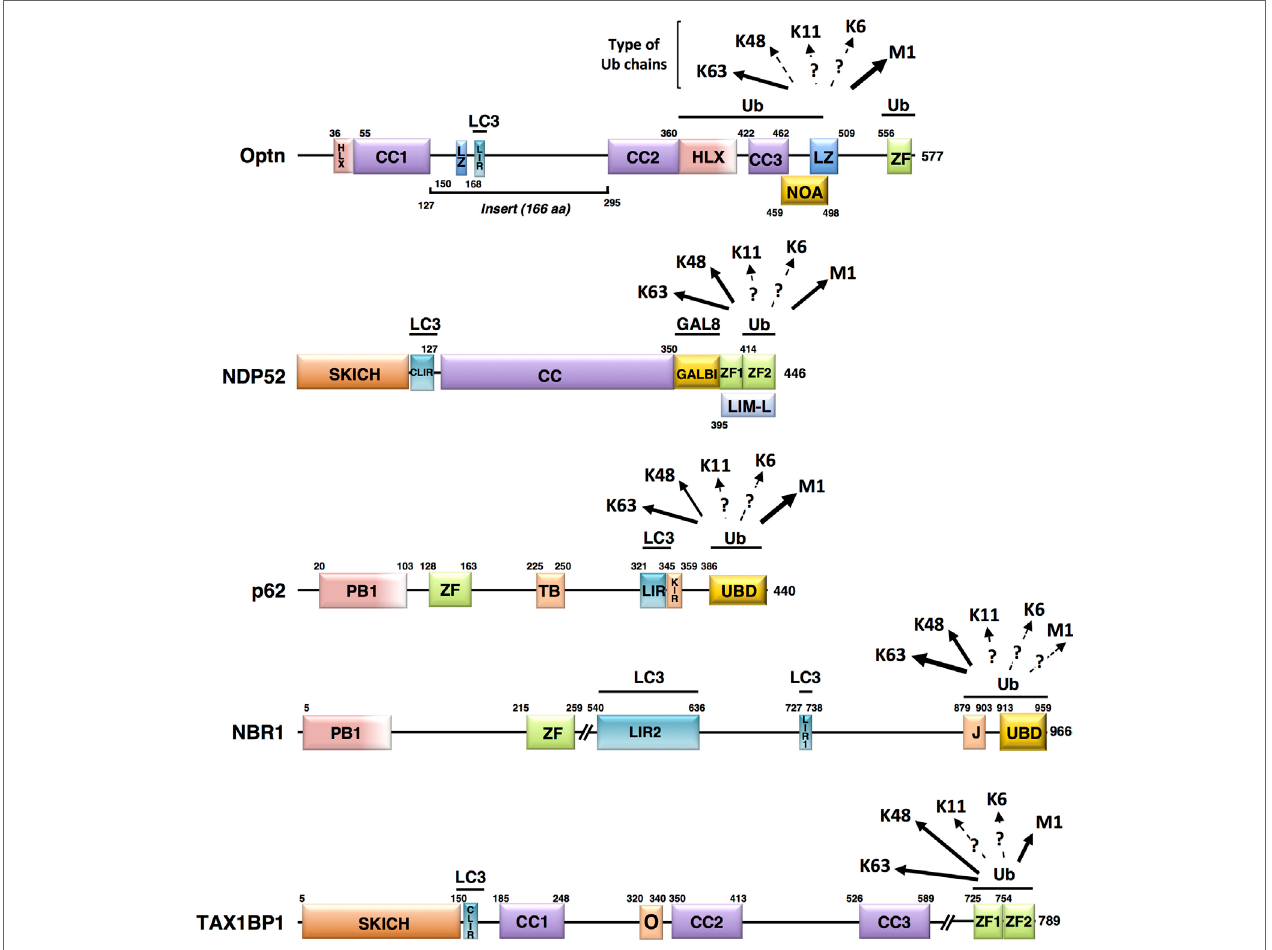
FigURe 2 | Schematic representation of the structural domains of the non-mitochondrial autophagy receptors involved in mitophagy. Each domain is represented, scaled according to its aa position [except for NBR1 and Tax1 binding protein 1 (TAX1BP1)] and delimitations are indicated. Abbreviations: HLX, helix-loop-helix; CC, coiled-coil; LZ, leucine zipper; ZF, zinc finger; LIR, LC3-interacting region; NOA, NEMO-optineurin (Optn)-ABIN domain; SKICH, SKIP carboxyl homology domain; CLIR, non-canonical LC3-interacting region; GALBI, galectin-8 binding region; LIM-L, Lin11, Isl-1, and Mec-3 (LIM)-like domain; PB, Phox and Bemp1 domain; TB, TRAF6-binding domain; KIR, Keap1-interacting region; UBD, ubiquitin-binding domain; J, α -helical J domain; O, homodimerization domain. Known preferential affinities of the autophagy receptors for the different ubiquitin chain types are presented according to the following references: Optn (37, 38); nuclear dot protein 52 (39); p62 (40, 41); NBR1 (42, 43), and TAX1BP1 (44,